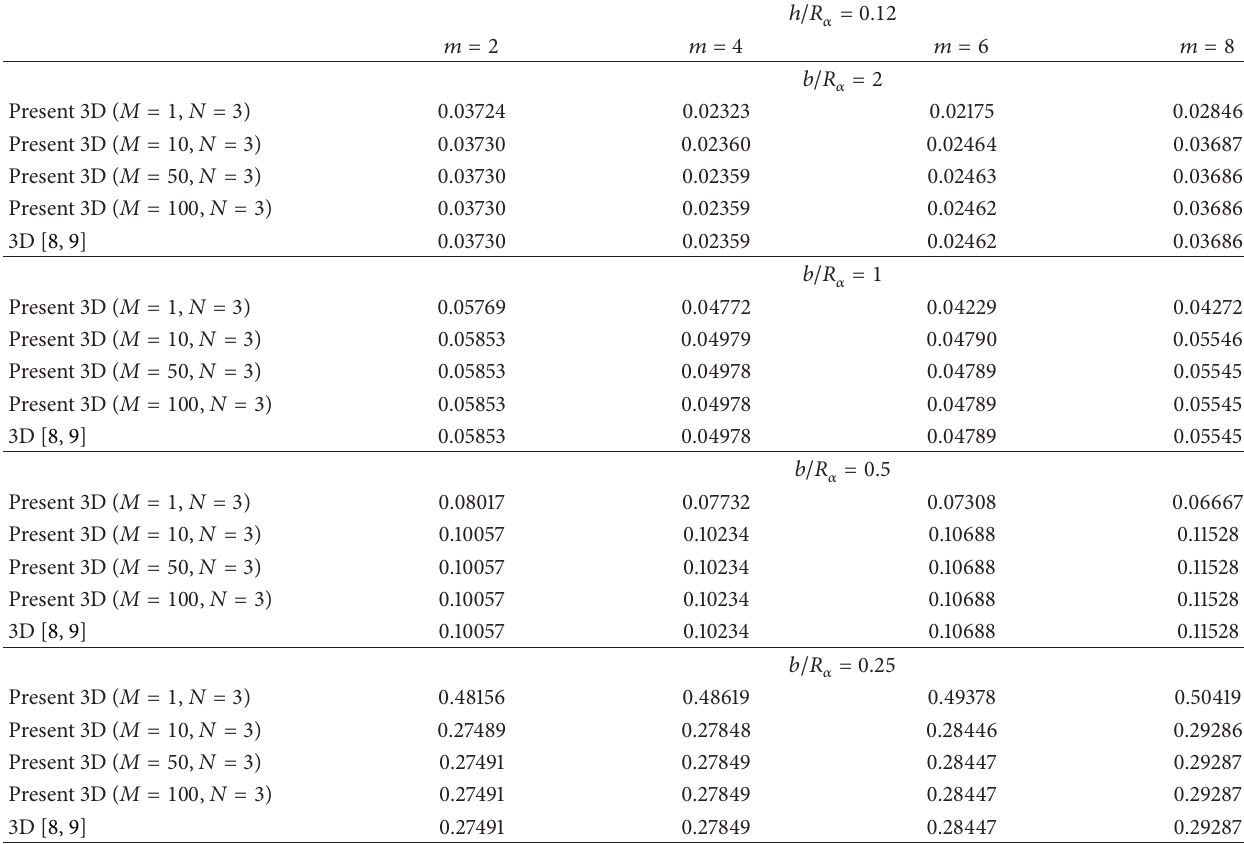
Table 2: Assessment 2 (part I). Simply supported aluminum cylinder with Poisson ratio ] = 0.3 and thickness ratio ℎ/𝑅 𝛼 = 0.12 . Lowest exact natural circular frequencies in no-dimensional form 𝜔 = 𝜔(ℎ/𝜋)√𝜌/𝐺 for imposed axial half-wave number 𝑛 = 1 and several half- wave numbers 𝑚 in circumferential direction. Comparison between present three-dimensional analysis and three-dimensional analysis by Armenakas et al. [8] as adapted in Bhimaraddi [9]. 𝑀 is the number of fictitious layers and 𝑁 is the order of expansion for the exponential